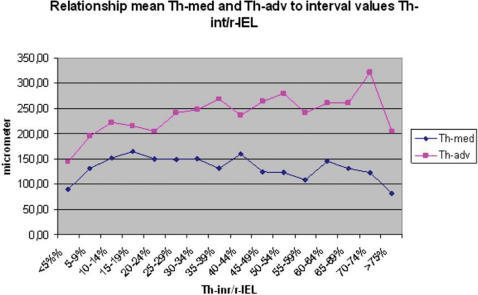
Line diagram relation mean thickness media (Th-med) and thickness adventitia (Th-adv) For 5% Th-int/r-IEL (thickness intima/radius Internal Elastic Lamina) intervals.